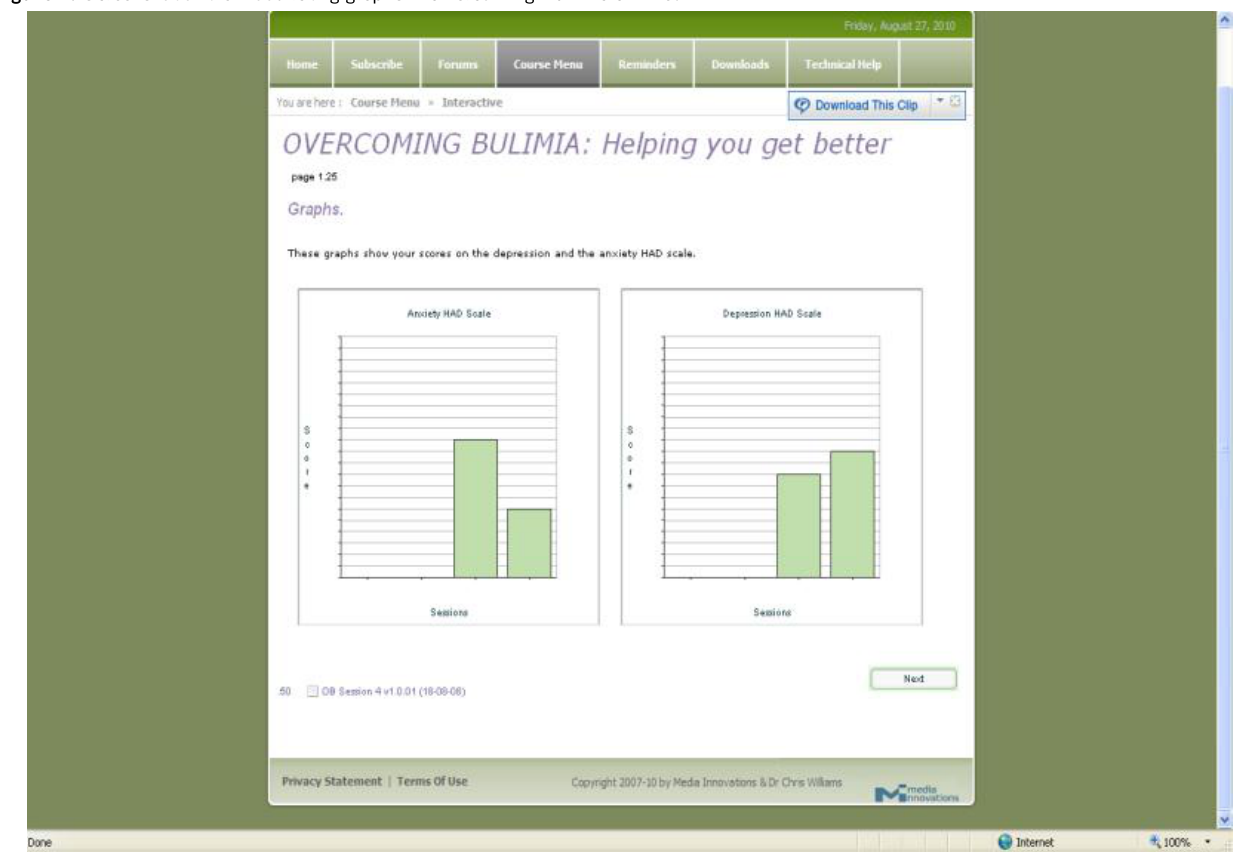
Figure 2. Screenshot of the mood rating graphs in Overcoming Bulimia